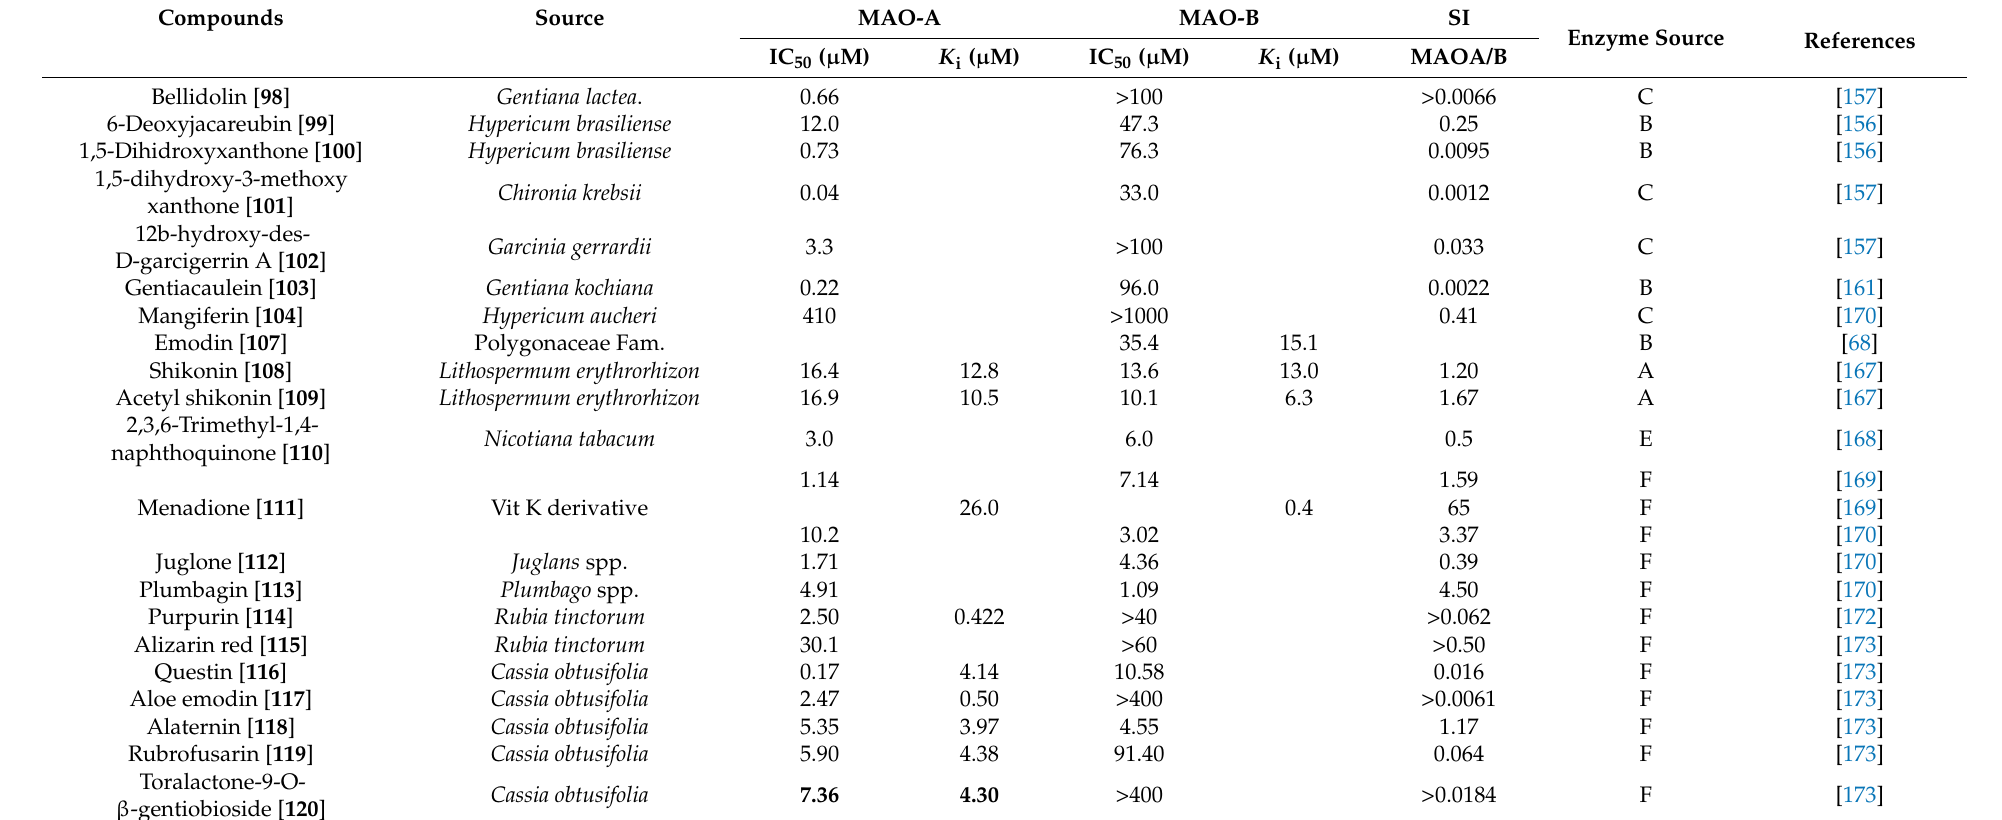
Table 5. Xanthone, anthraquinone, and naphthoquinone natural product inhibitors of MAO-A and MAO-B. Compounds Source MAO-A